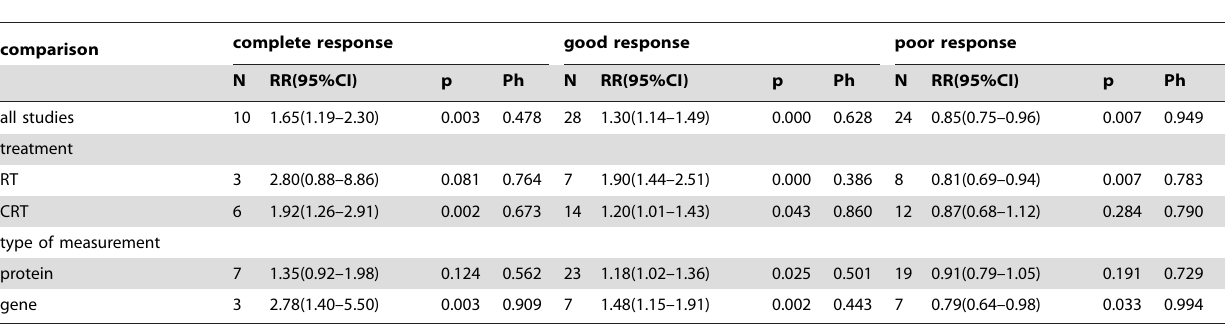
Table 3. Risk ratio for the association between wild-type form of TP53 and the response to neoadjuvant radiation-based